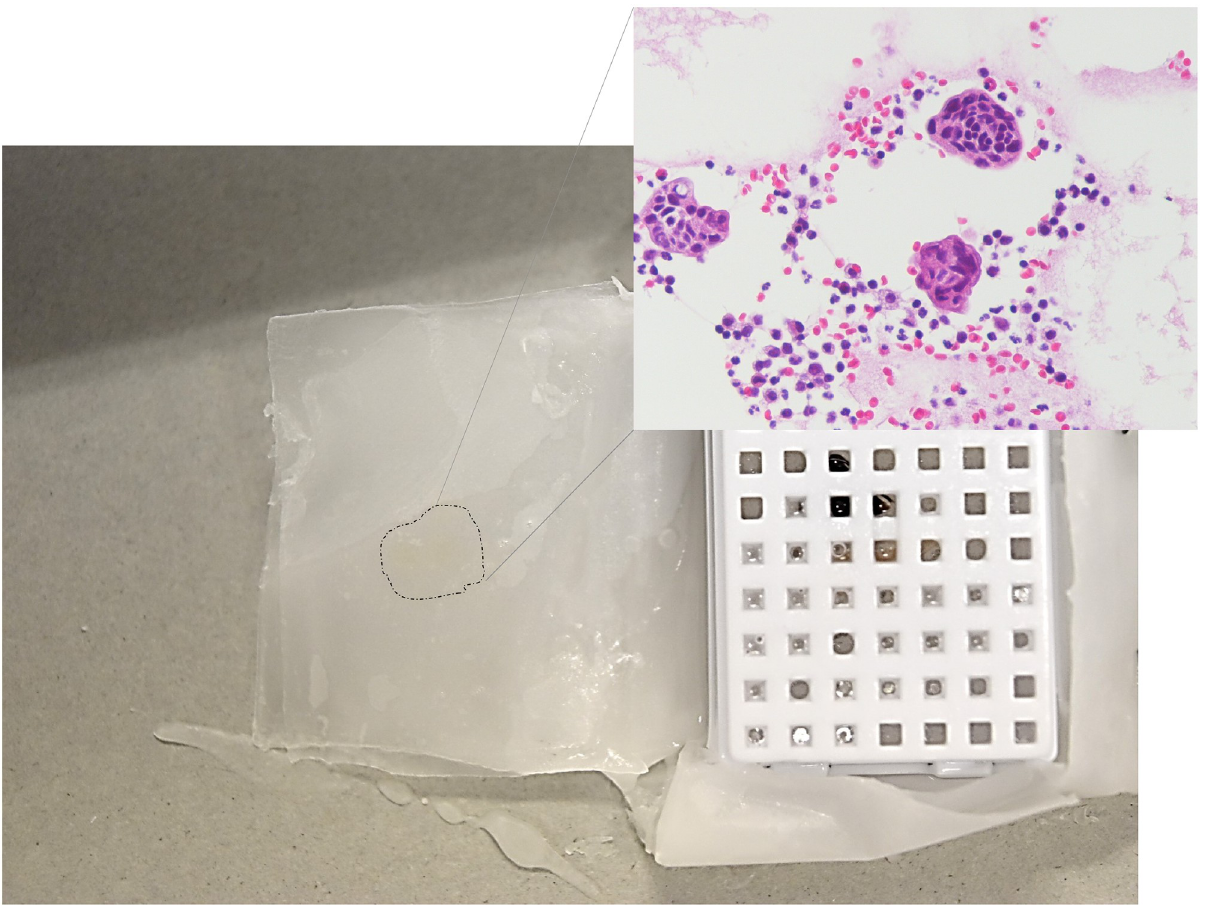
Fig 6. Detection of cells dissociated from cell pellet placed in the cassette. After paraffin impregnation, a slightly yellow smudge was detected on the sheet. A section of the sheet was prepared in this area for H&E staining. Cancer and inflammatory cells were observed on the surface of the